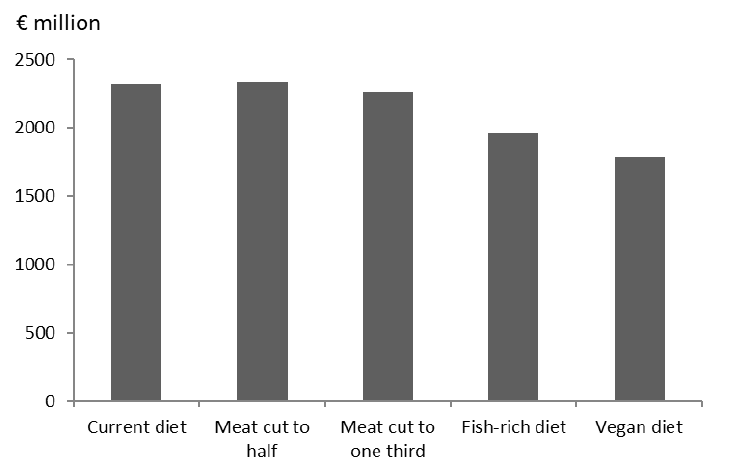
Fig. 4. Primary agricultural output (€ million) according to the input-output